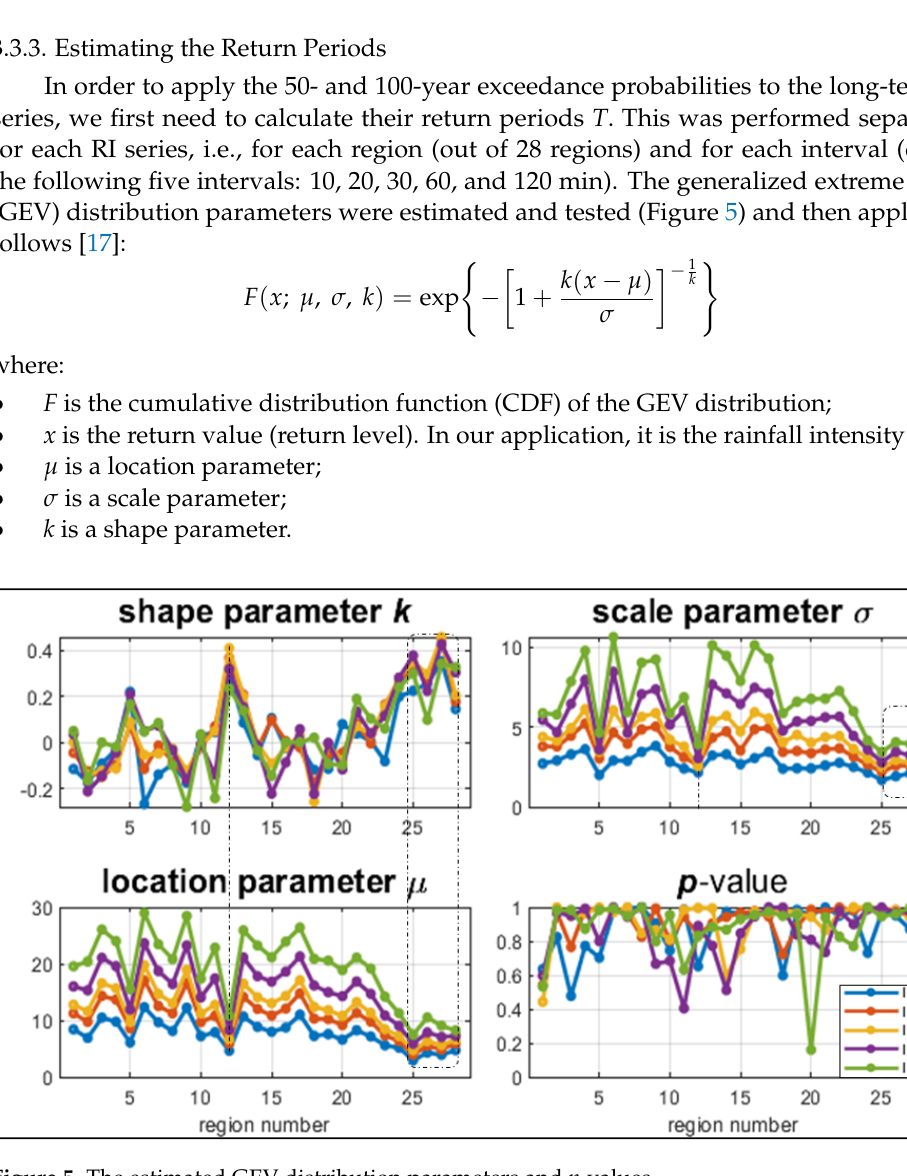
Figure 5. The estimated GEV distribution parameters and p -values.